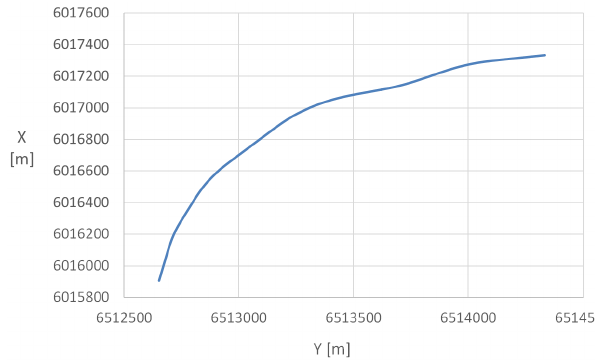
Figure 1: Illustrative segment of the railway route in the national space reference system